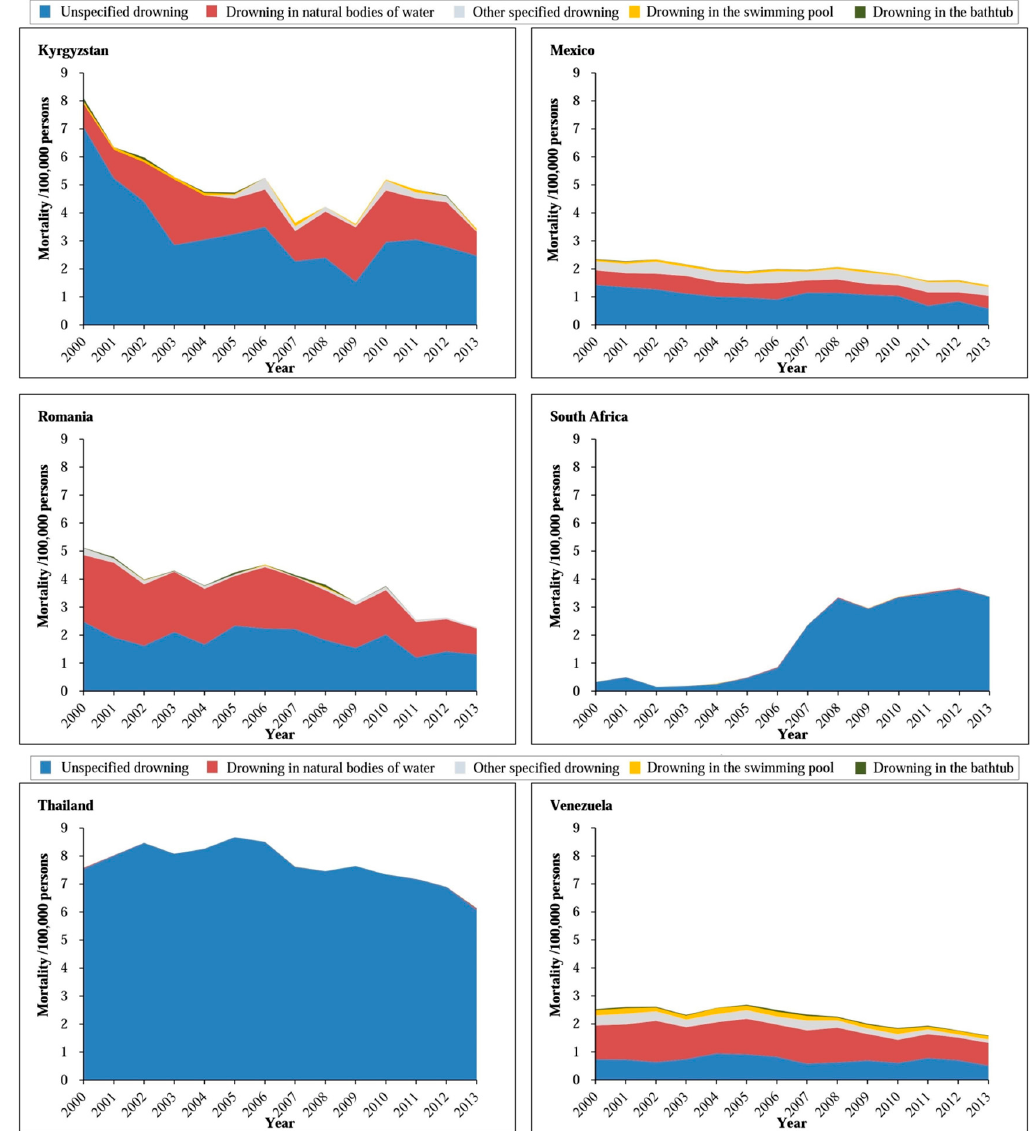
Figure 1. Trends in the method of under-20 unintentional drowning rate in 14 low- and middle-income countries, 2000–2013.